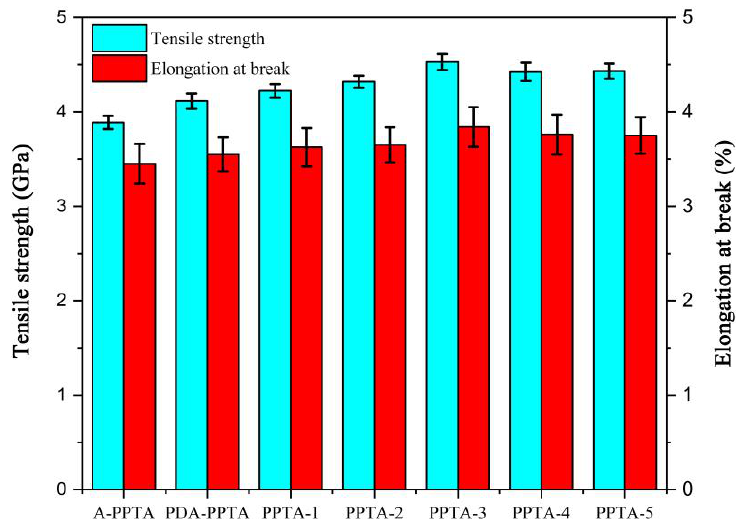
Figure 7. The mean values of single-filament tensile strength and elongation at break of PPTA fibers. The single-filament tensile strength (GPa) of PPTA fibers was 3.89 ± 0.07, 4.11 ± 0.08, 4.22 ± 0.07, 4.32 ± 0.06, 4.53 ± 0.08, 4.42 ± 0.10 and 4.43 ± 0.08, respectively. The elongation at break (%) was 3.45 ± 0.21, 3.55 ± 0.18, 3.63 ± 0.20, 3.65 ± 0.18, 3.84 ± 0.21, 3.76 ± 0.21 and 3.75 ± 0.19, respectively. As